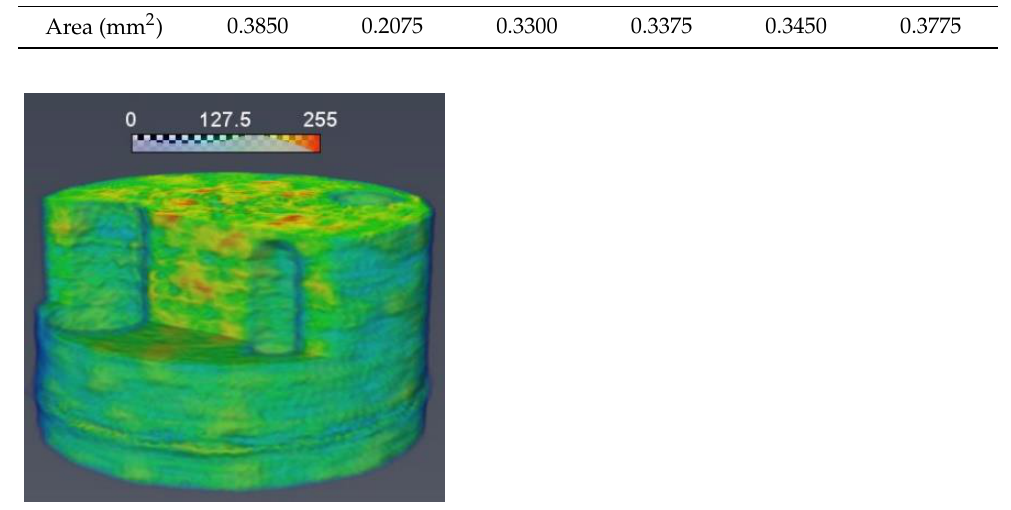
Figure 13. A 3D image of several series of slices. A part of the 3D image is removed so that the internal structure can be seen clearly.